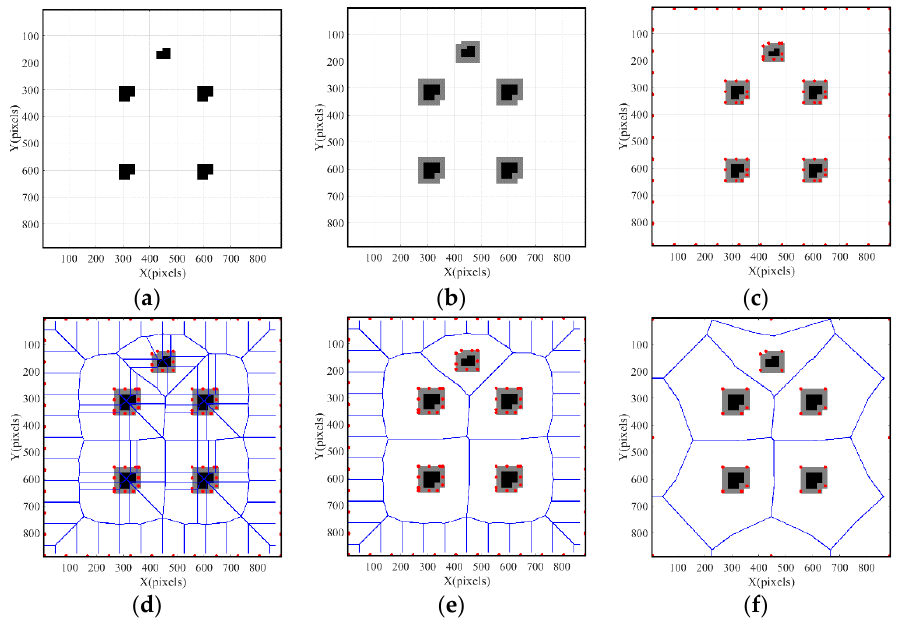
Figure 2. ( a ) The input obstacle map; ( b ) safety margins are added; ( c ) Voronoi corners are detected; ( d ) VD division, ( e ) GVD division, and ( f ) GVD division with few extra corners. ( d ) VD division, ( e ) GVD division, and ( f ) GVD division with few extra